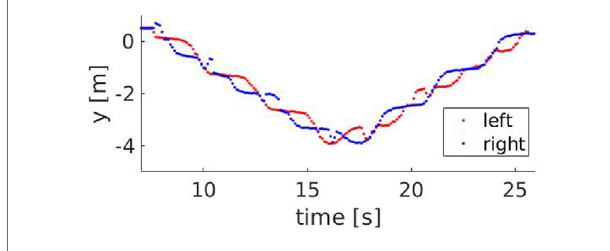
FIGURE 7 | The y component of the left (red) and right (blue) ankle for a speed of 0.9 m/ s .